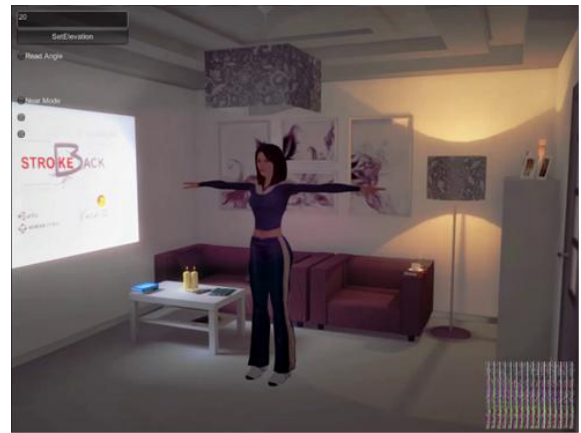
Figure 12. Avateering in a “home” like environment